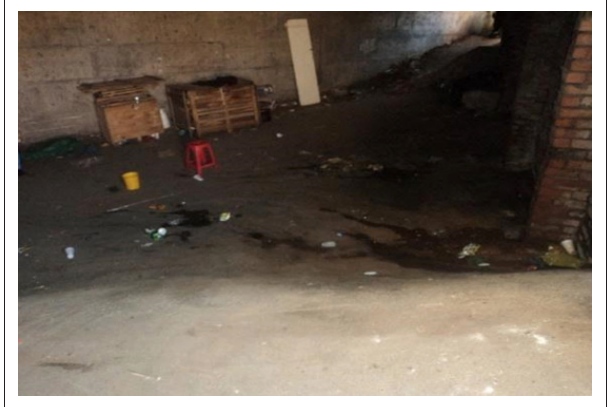
FIGURE 6: Abandoned storage facility located outside the bead market utilised as an ablution facility.